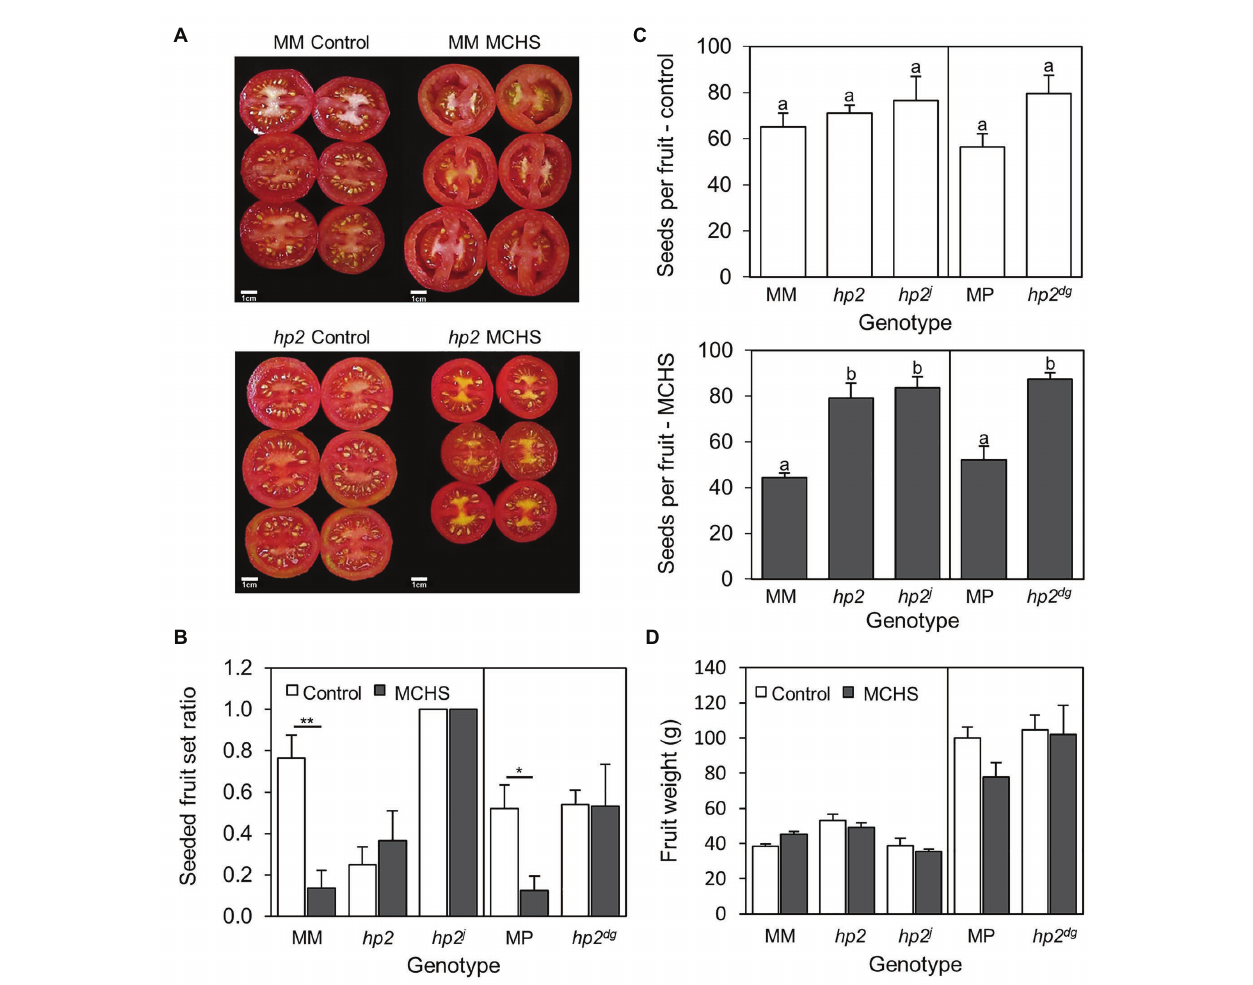
FIGURE 1 | The hp2 mutant maintains normal seed production under MCHS conditions. (A) Visual differences in fruit seed set between hp2 and Moneymaker under control and MCHS conditions. (B) Rates of fruits full of seeds, under control and MCHS conditions. Fruits were scored as “full of seeds” when visually similar to fruits shown in (A) for control conditions. (C) Number of seeds per fruit under control (upper panel) and MCHS conditions (bottom panel). (D) Single fruit weight under control and MCHS conditions. About 5–10 ripe fruits (from 8 to 10 plants per genotype per condition) were analyzed in three replicates. Error bars represent SEM. *represents p < 0.05 and **represents p < 0.01. Different letters indicate statistically significant differences. MCHS, moderate chronic heat stress; MM, moneymaker; and MP,